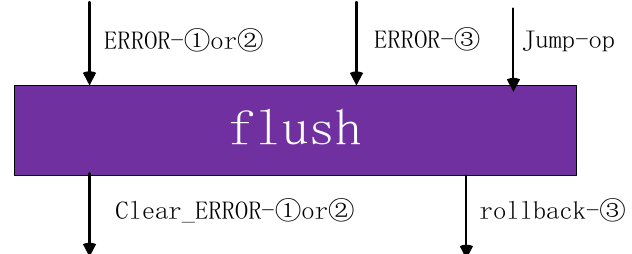
Figure 14. Flush module: The module is embedded in the ARBIT module to determine whether the current instruction needs to be refreshed according to the received error type, priority, and instruction type. If there is an error appearing in the levels of the first–third stage, the jump situation needs to be determined.